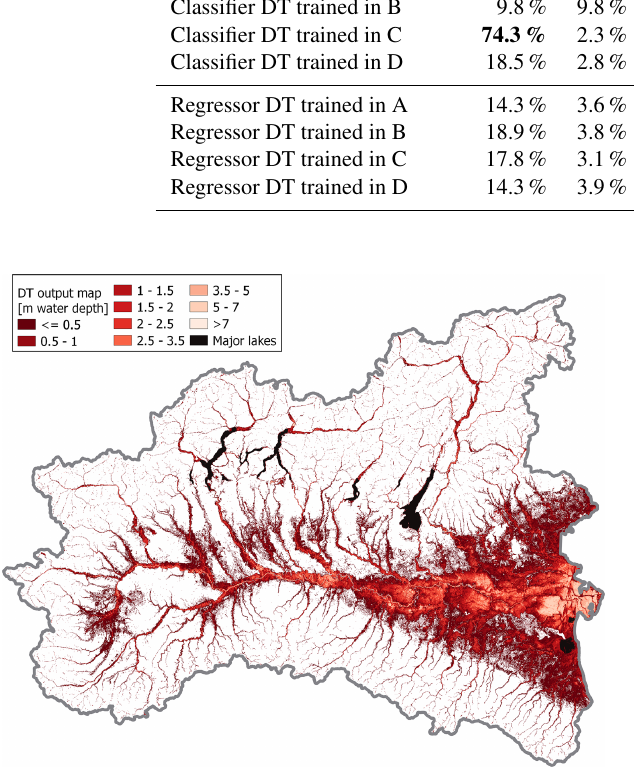
Figure 9. Multivariate water depth hazard map obtained with regressor DT in interpolation mode (target flood hazard map: JRC 100).